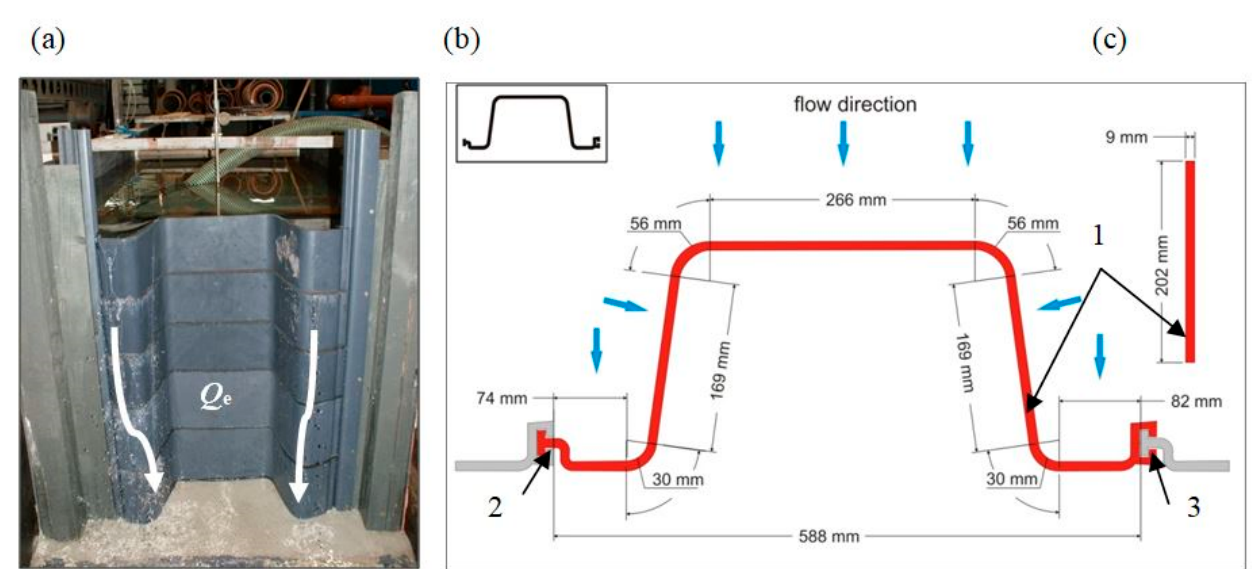
Figure 4. Measurement diagram of the U labyrinth regulator: ( a ) measuring station, ( b ) regulator mounting, ( c ) cross-section of the beam: 1—beam; 2—gib with female lock; 3—gib with a male lock (photo by Z. Popek).